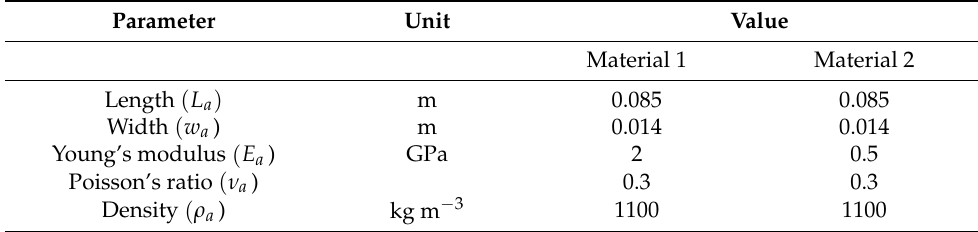
Table 7. Electromechanical properties of the added layers.